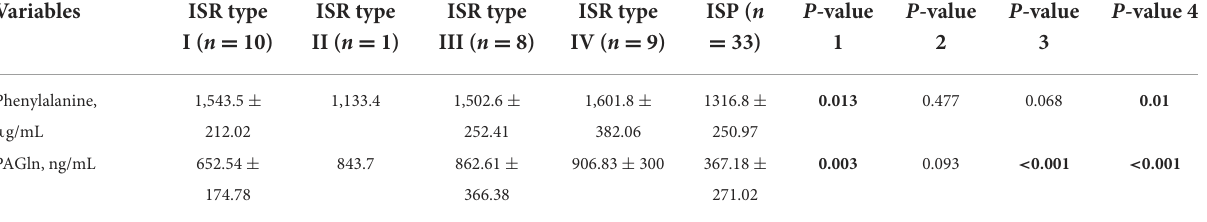
TABLE 3 Plasma phenylalanine and PAGln levels in ISR